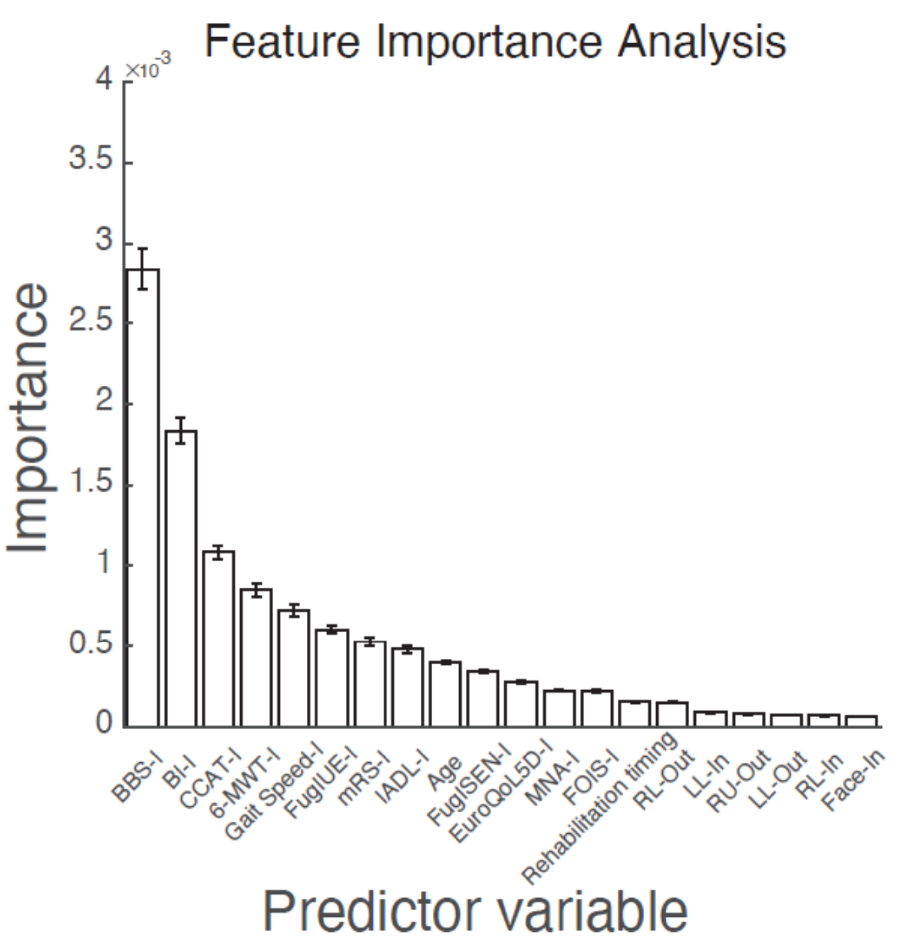
Figure 2. Feature importance of the random forest machine-learning model, indicating the 20 most important predictors. The “-I” represents the initial functional assessments at the PAC-CVD hospital. The “-In” and “-Out” represent the initial and final National Institute of Health Stroke Scale at the acute management ward. Error bars indicate the mean ± standard error. PAC-CVD: Post-Acute Care-Cerebrovascular Disease; BBS: Berg Balance Test; BI: Barthel Index; CCAT: Concise Chinese Aphasia Test; 6-MWT: 6-Minute Walk Test; FuglUE: Fugl–Meyer Upper Extremity Assessment; mRS: modified Rankin Scale; IADL: Lawton–Brody Instrumental Activities of Daily Living Scale; FuglSEN: modified Fugl–Meyer Sensory Assessment; Euro-QoL-5D: European Quality of Life Five-Dimension Questionnaire; MNA: Mini-Nutritional Assessment; FOIS: Functional Oral Intake Scale; LU: motor of the left arm; RU: motor of the right arm; LL: motor of the left Leg; RL: motor of the right Leg; Face: facial palsy.